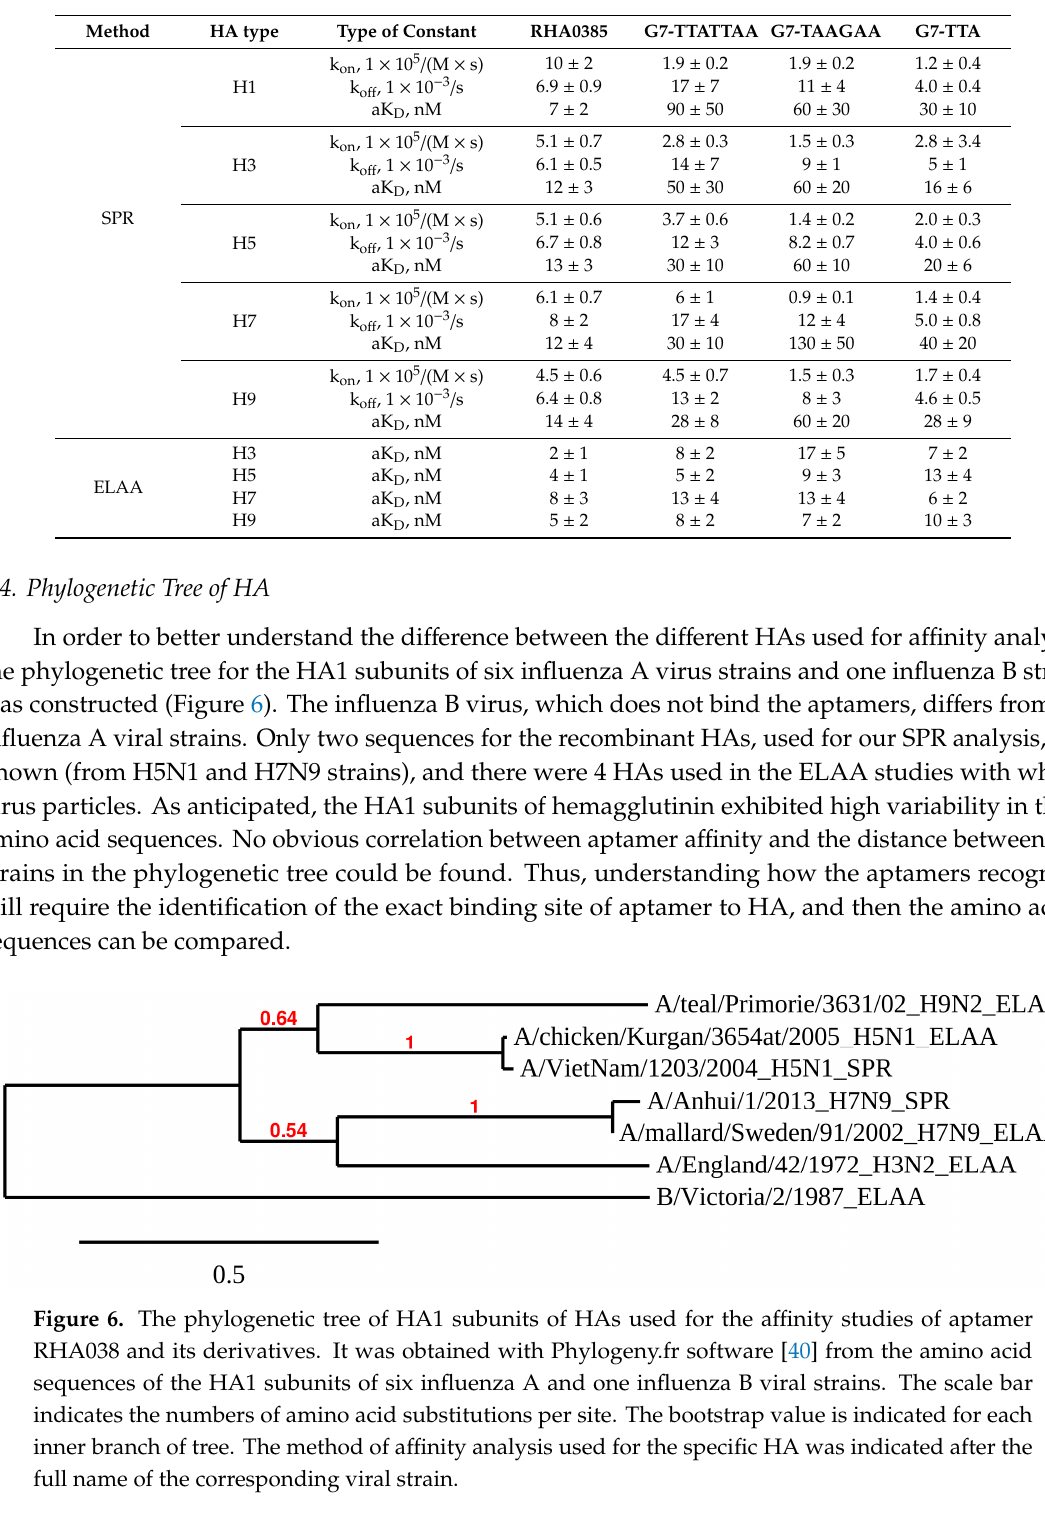
Table 2. Apparent dissociation constants aK D and rate constants k on and k o ff of aptamer–HA complexes, calculated from SPR (with recombinant HA) and ELAA (with viral particles) data. The influenza A viral strains for ELAA analysis are A / England / 42 / 1972 (H3N2), A / chicken / Kurgan / 3654at / 2005 (H5N1), A / mallard / Sweden / 91 / 2002 (H7N9), A / duck / Primorie / 3628 / 2002 (H9N2).